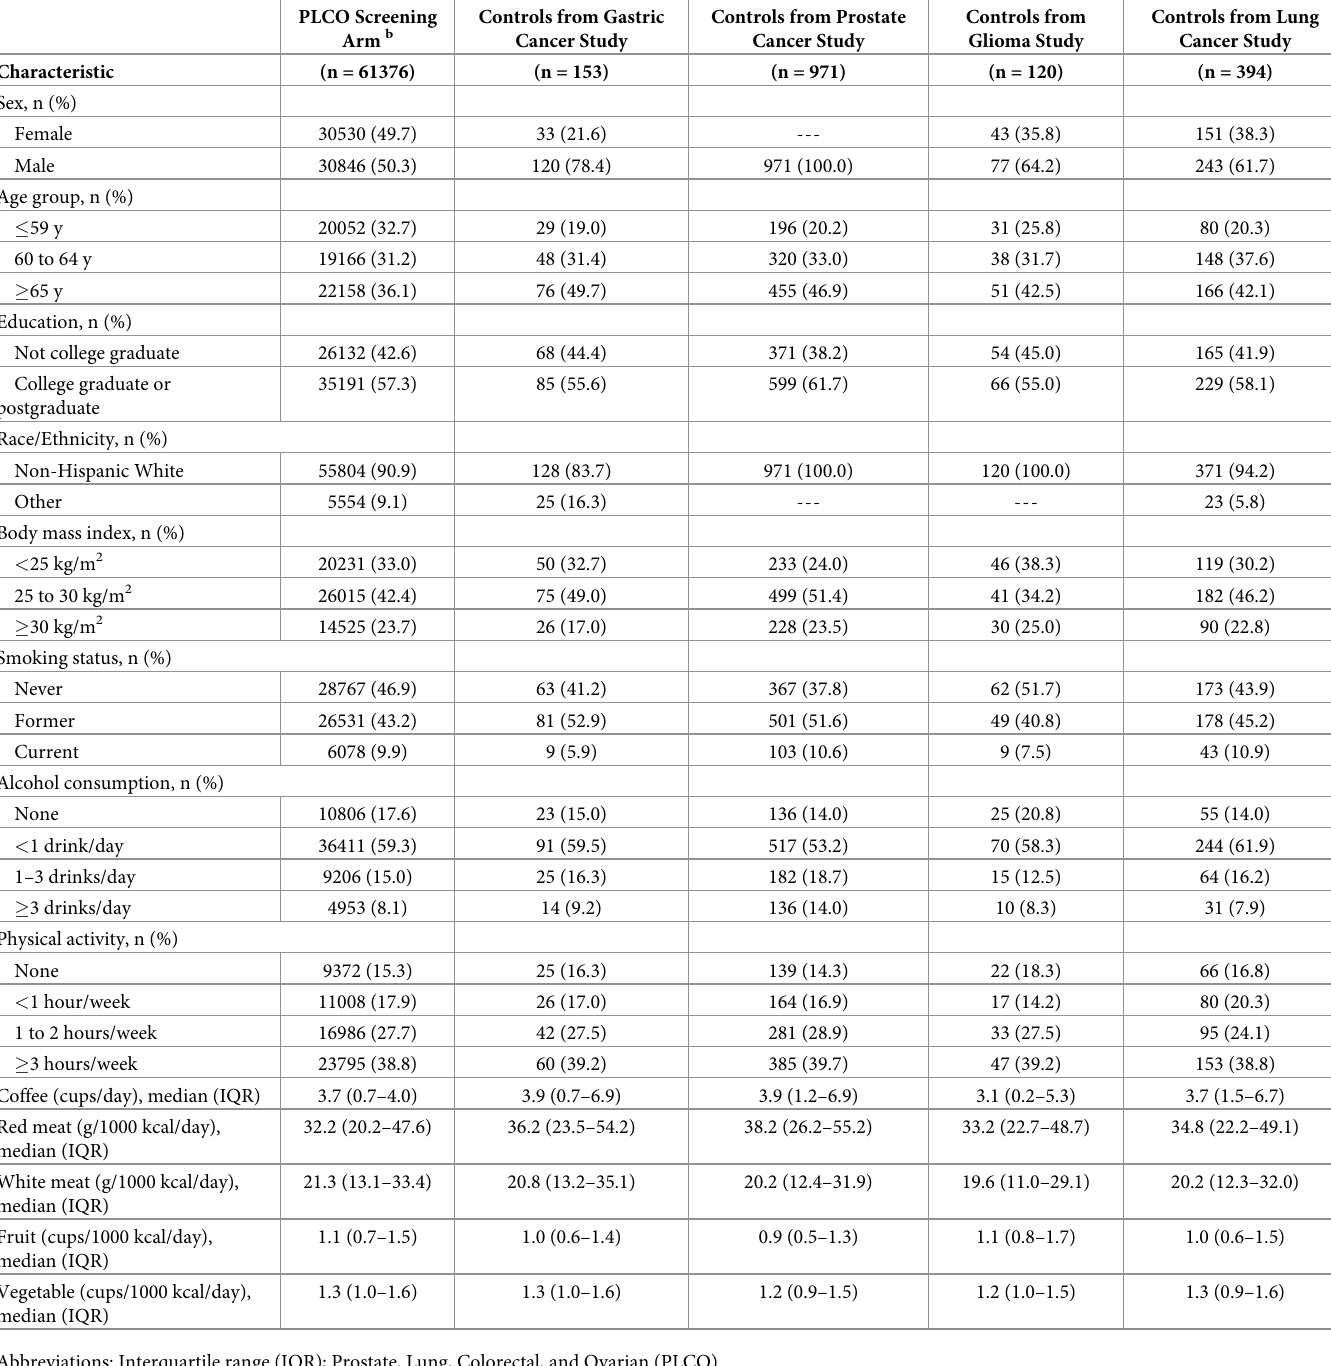
Table 1. Baseline characteristics of the PLCO Cancer Screening Trial screening arm and controls in four nested case-control studies within PLCO a